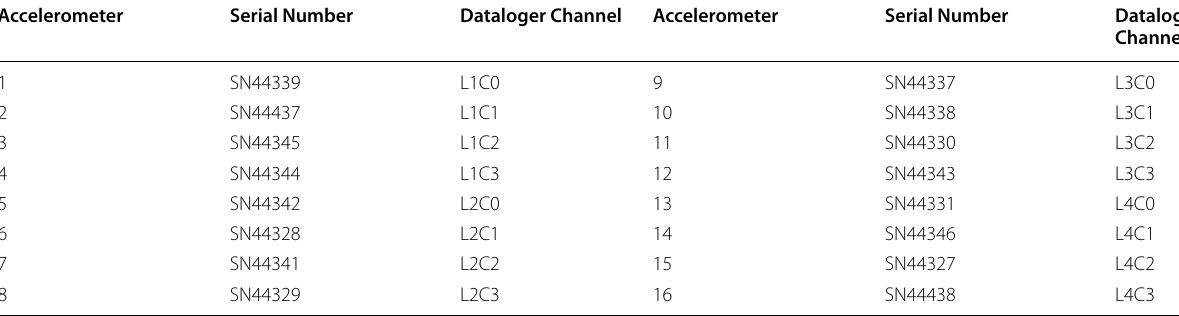
Table 1 Accelerometer serial numbers and datalogger channels